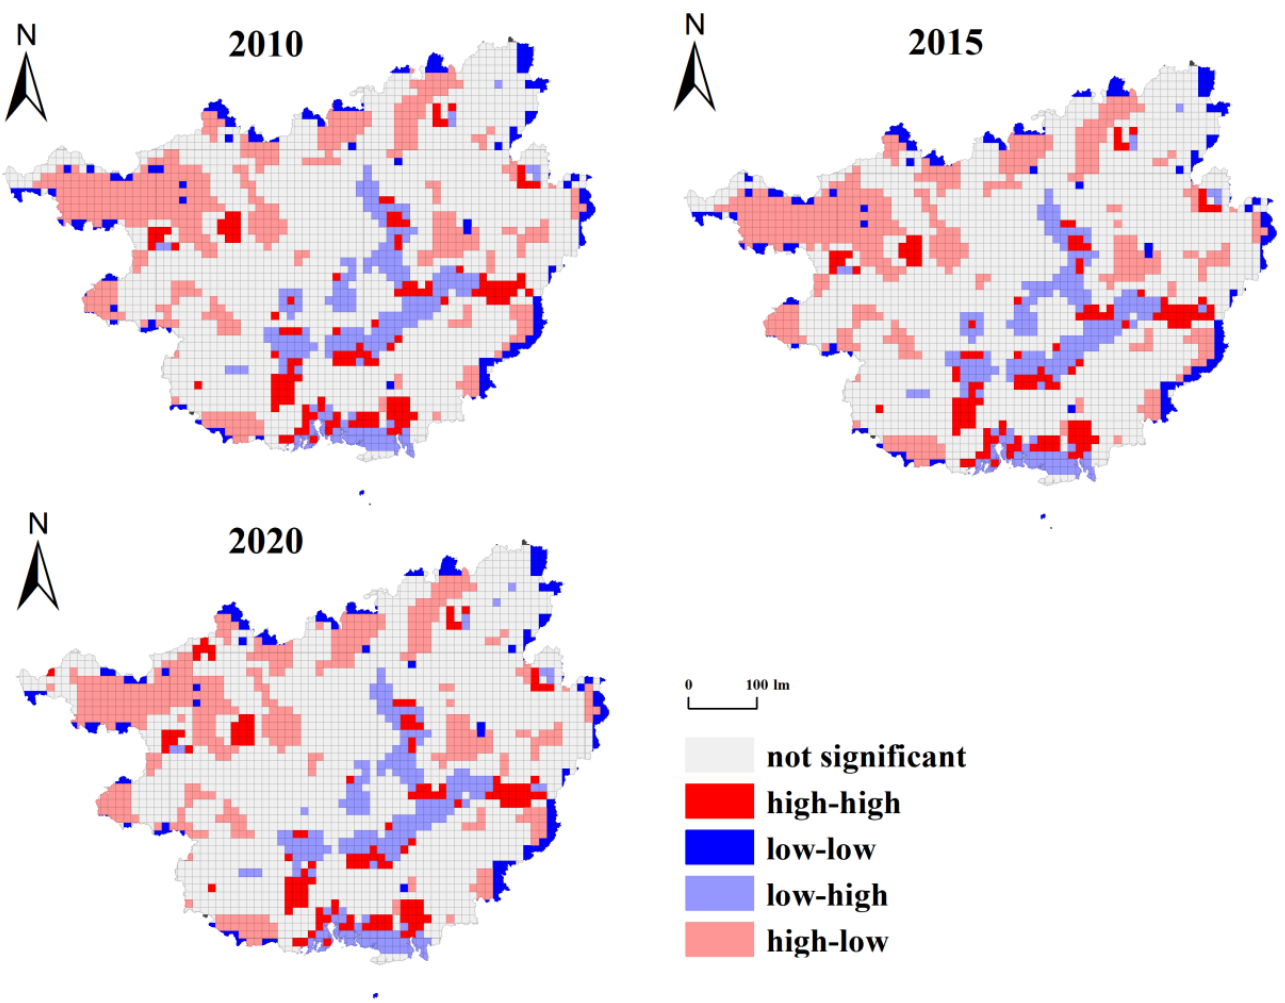
Figure 7. Bivariate local spatial autocorrelation distribution maps of ecological-economic values. 4.4. Standard Deviation Ellipse Analysis of Ecological-Economic